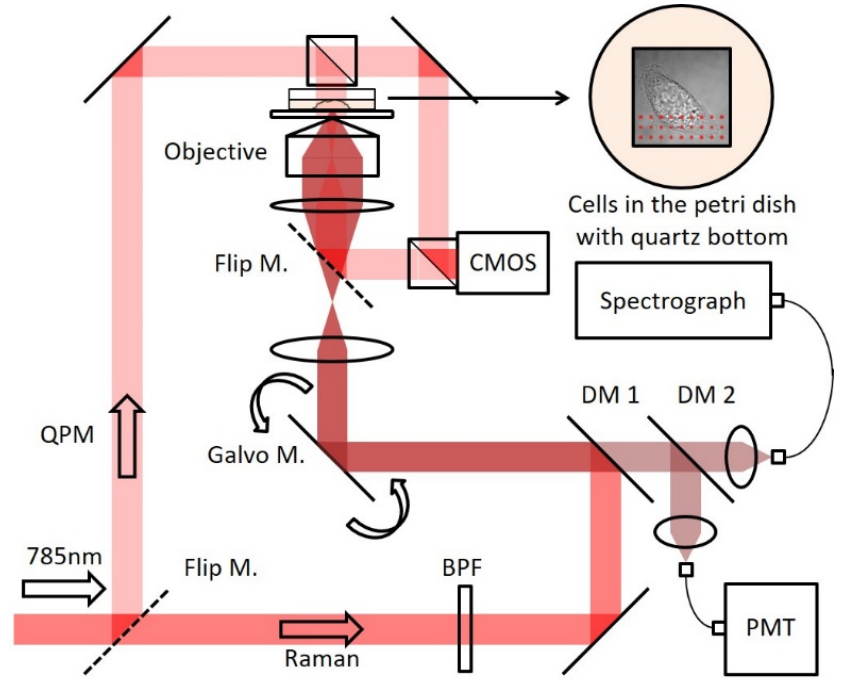
Figure 1. Schematic diagram of confocal Raman and quantitative phase microscopy system.